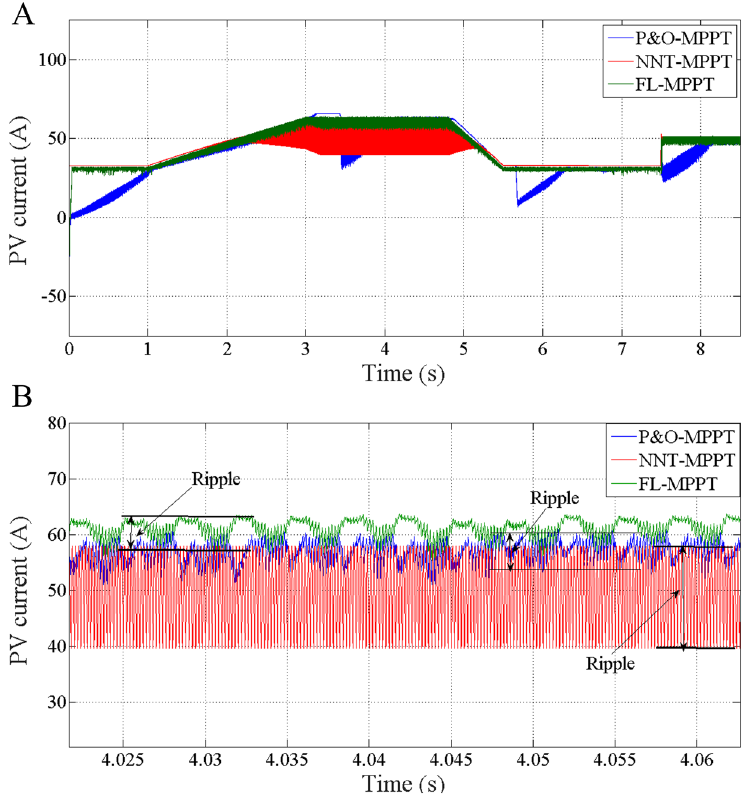
Fig. 16 a PV current. b PV current zoom